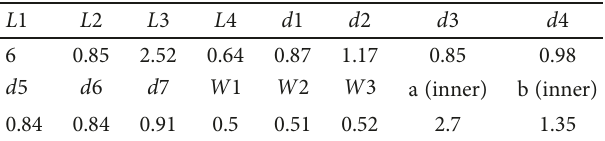
Figure 4: Internal structure of the secondary feed divider. Table 1: Optimized dimensions of the waveguide feed network (all dimensions are in mm).